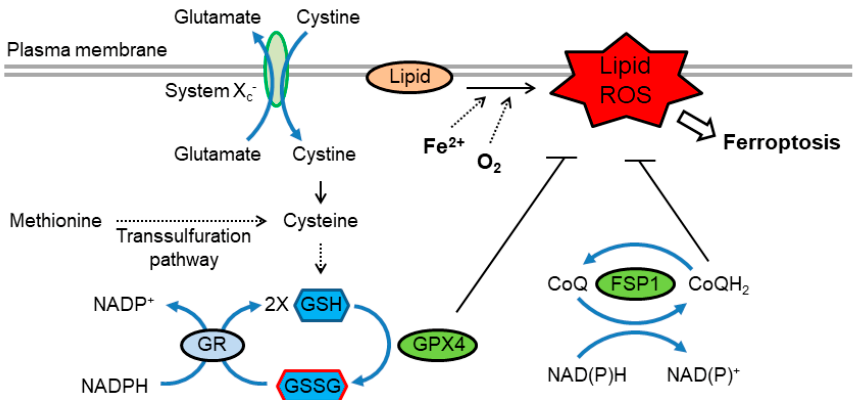
Figure 3. Redox regulation of ferroptosis. Ferroptosis is driven by lipid peroxidation, which is catalyzed by redox-active iron. Cysteine availability, which is regulated by cystine uptake via system x c- or through the transsulfuration pathway, is essential for efficient synthesis of GSH. GPX4 utilizes GSH to reduce lipid hydroperoxides, thereby suppressing ferroptosis. GSSG is reduced to GSH by GR using NADPH. In addition, reduced coenzyme Q (CoQH 2 ) acts as a lipophilic radical-trapping antioxidant that halts the propagation of lipid peroxidation. The CoQ oxidoreductase ferroptosis suppressor protein 1 (FSP1) maintains CoQH 2 levels and acts parallel to GPX4 to inhibit ferroptosis. FSP1, ferroptosis suppressor protein 1; GSH, glutathione; GPX4, glutathione peroxidase 4; GSSG, glutathione disulfide; GR, glutathione reductase.